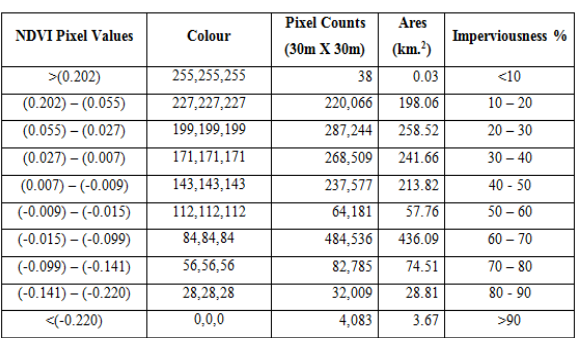
Figure 9 . Impervious area with corresponding Imperviousness percentage